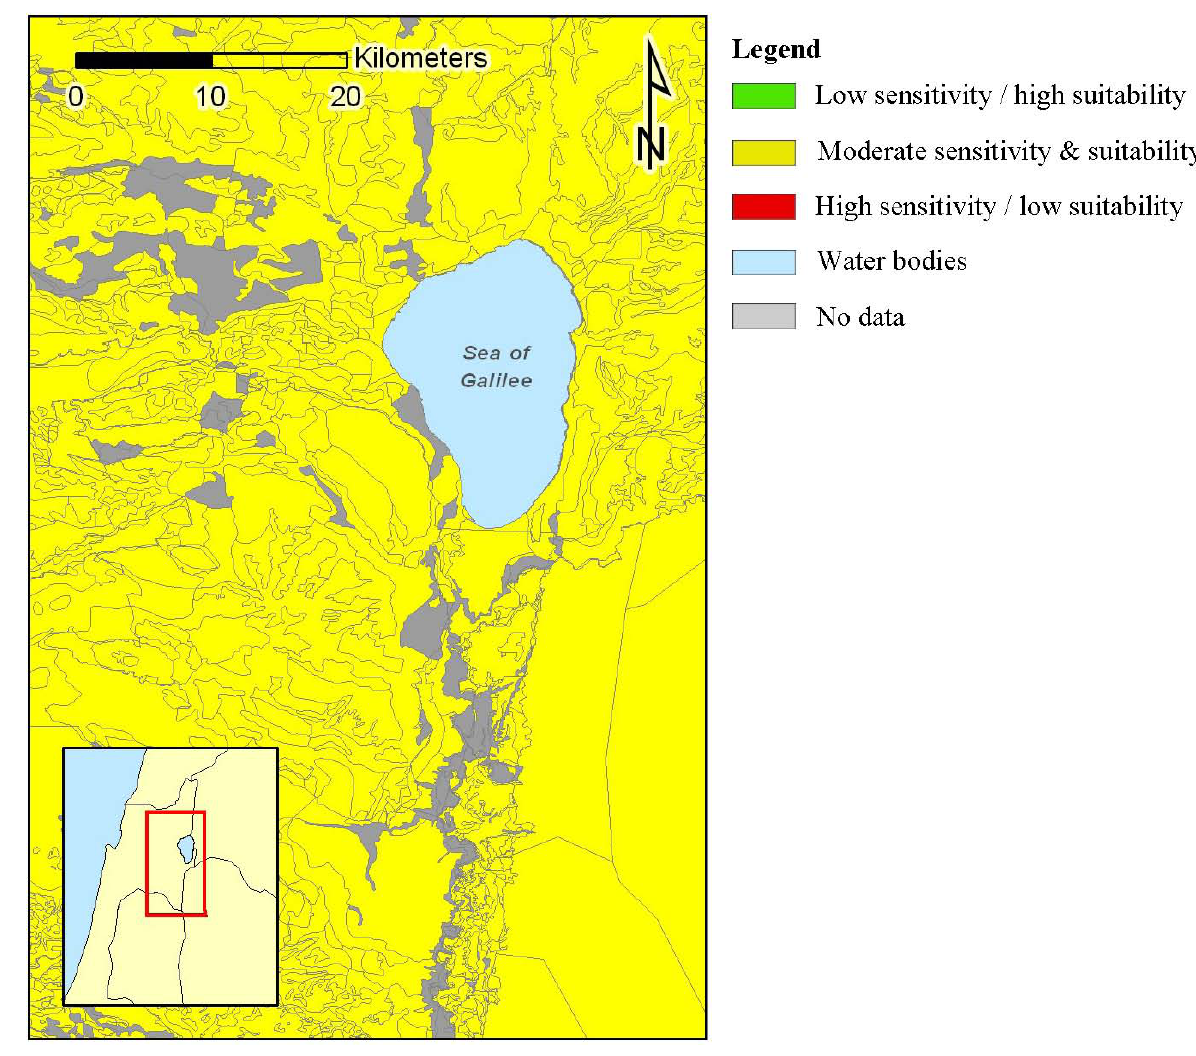
Figure 7. Cut-out of the assessment map visualizing sensitivity F: Sensitivity towards hydrophobicity (scale 1: